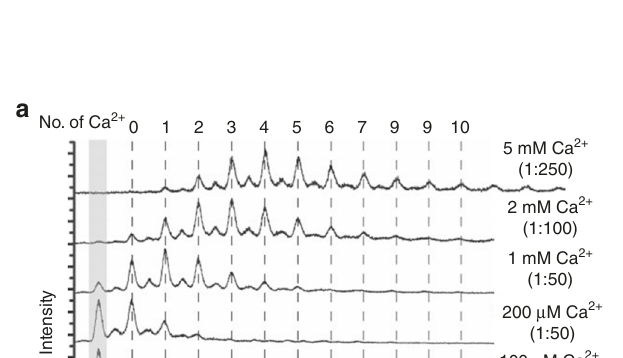
Fig. 4 ThT-based aggregation assays reveal different aggregation behaviour for aSyn familial mutants. Aggregation kinetics of aSyn WT and familial mutants A30P, A53T, E46K, A53E, H50Q, G51D were measured using ThT fl uorescence intensity and plotted as % of maximum fl uorescence a in the absence of calcium and b in the presence of 2.5 mM CaCl 2 (plate repeat data are available in Supplementary Fig. 12). 20 μ M aSyn was incubated with 20 μ M ThT in a half area 96 well plate with orbital agitation at 300 rpm for 5 min before each read every hour for 150 h. c Lag time ( t lag ) and d time to reach 50% of maximum aggregation ( t 50 ) were calculated and the mean is numerically shown ( t lag : * p = 0.0145, ** p = 0.0034, *** p = 0.001, t 50: ** p = 0.001, *** p = 0.0003, *** p = 0.0004, * p = 0.043, * p = 0.002)). Mutant G51D did not reach the elongation phase in the studied timeframe, so the t 50 value was not calculated in ( c ). e The remaining monomer concentration was determined using SEC-HPLC, 35 μ L of monomer from each well in the ThT assays was analysed on an AdvanceBio SEC 130 Å column in 20 mM Tris pH 7.2 at 1 mL min − 1 . Remaining monomer concentrations were measured from the area under the peak and calculated using a standard curve of known concentrations. The mean remaining monomer concentration is numerically shown (* p = 0.0438, * p = 0.0466). Measurements were repeated using at least four sample replicates in three experiments and an unpaired two-tailed t -test with a 95% con fi dence interval was used to calculate statistical signi fi cance between samples before and after the addition of calcium. Error bars represent s.d.